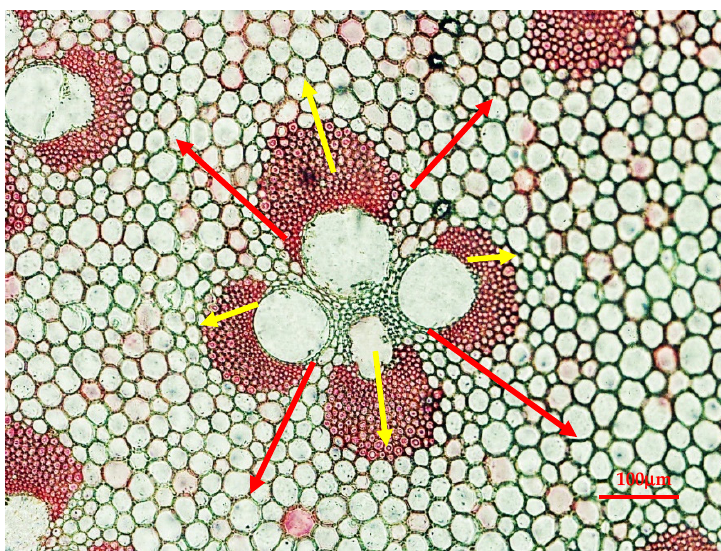
Figure 1. Schematic diagram of measure method about the wall thickness and lumen diameter of fiber cell and parenchyma. In the figure of the permanent section, a vascular bundle in BT was selected. According to the direction of the yellow arrow, the fiber cell was selected in turn to obtain the double-wall thickness and lumen diameter, and according to the direction of the red arrow, the parenchyma was also selected.